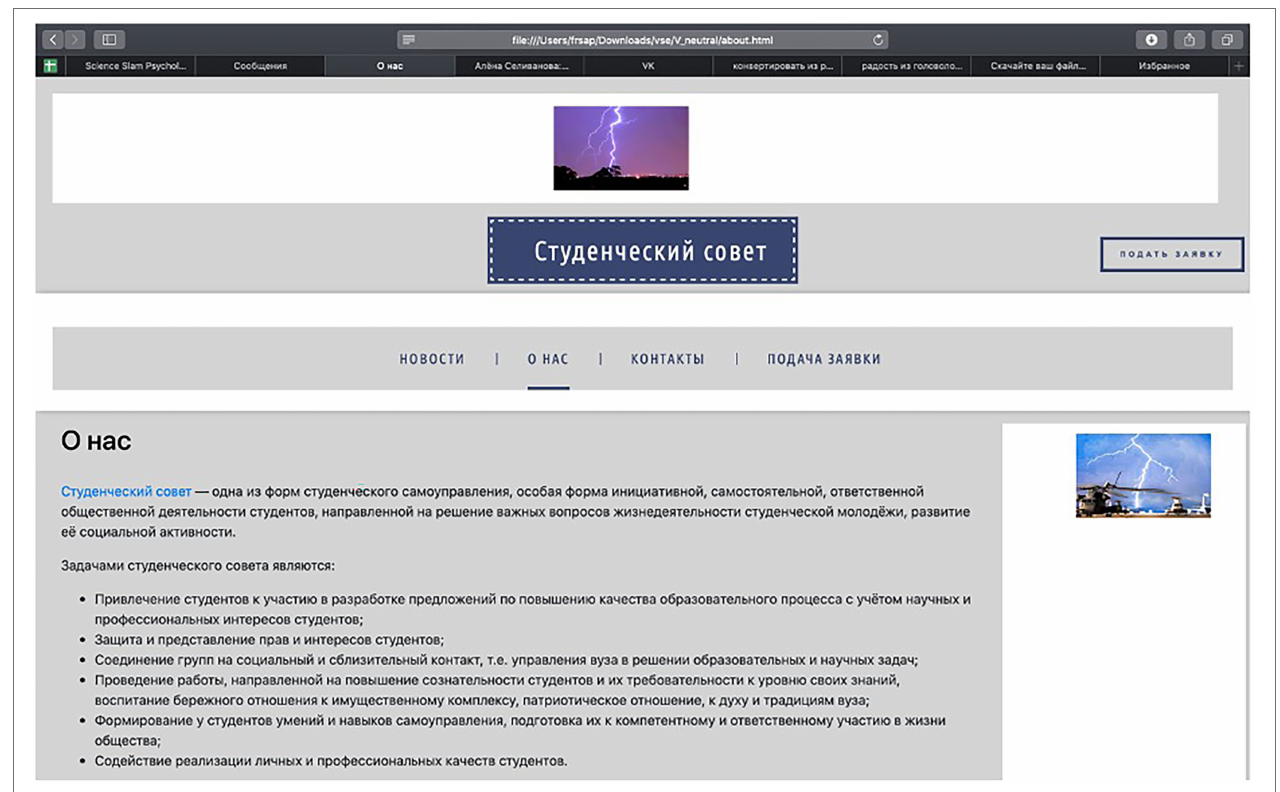
FIGURE 2 | Example of the